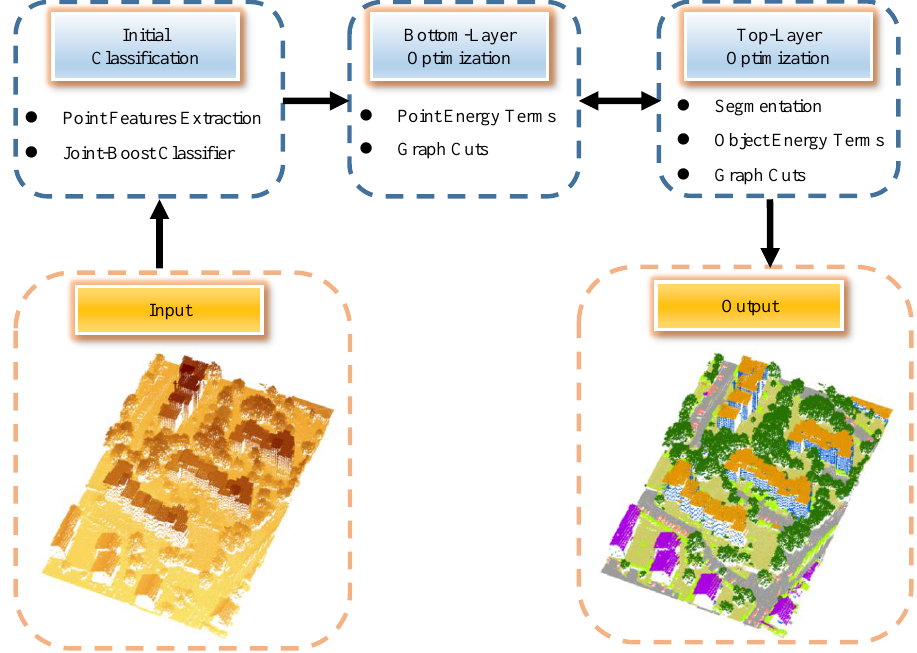
Initial Classification